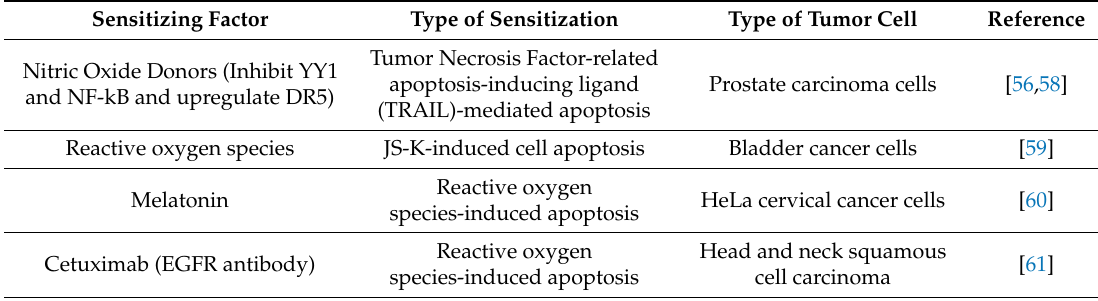
Table 2. Examples of Sensitizing Agents that Induce Apoptosis of Tumor